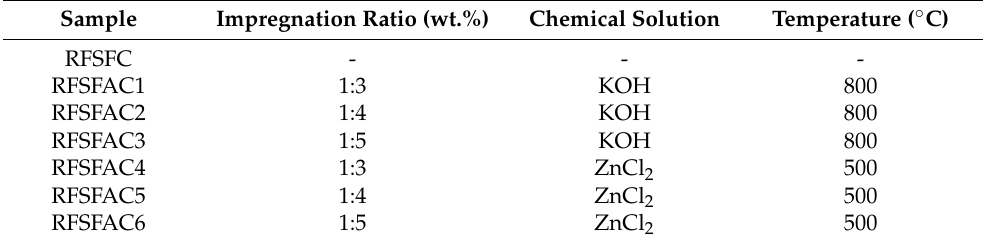
Table 1. Chemical activation process